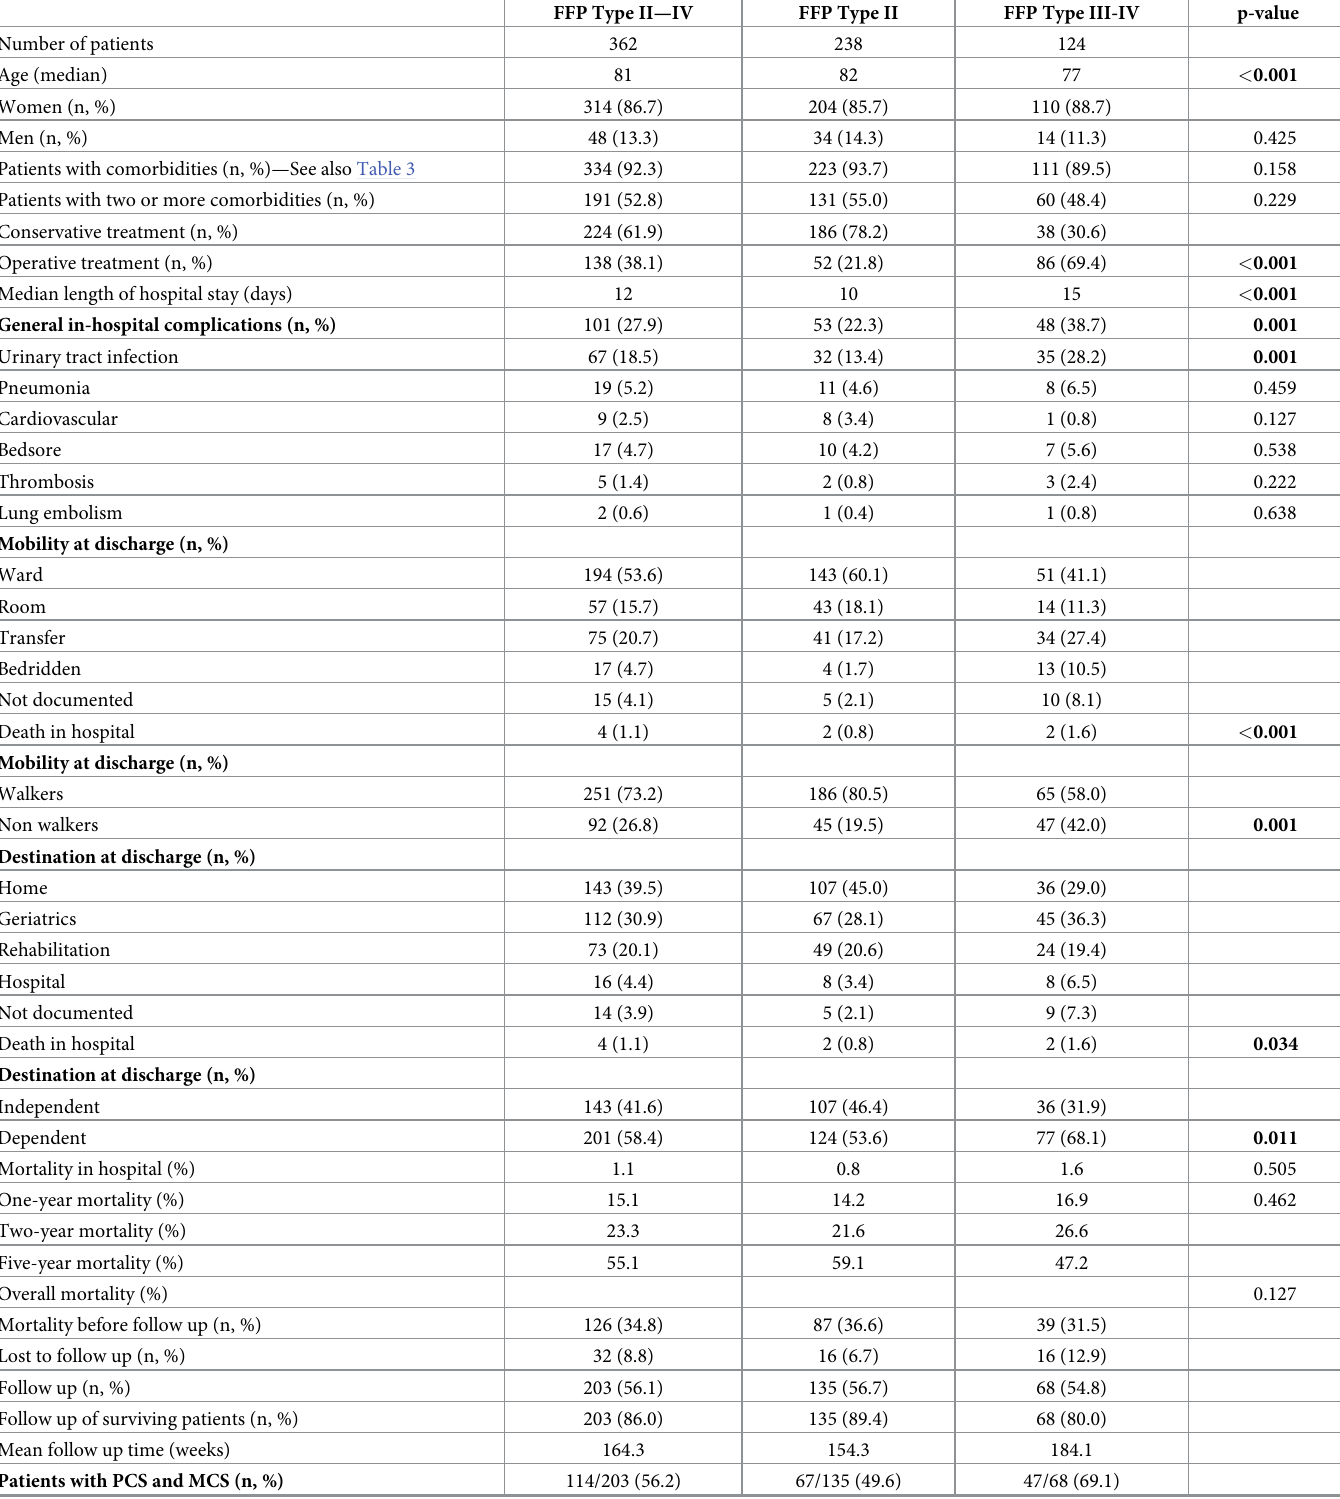
Table 1. Demographics, type of treatment, LoS, mortality and data at follow up of all patients, depending on